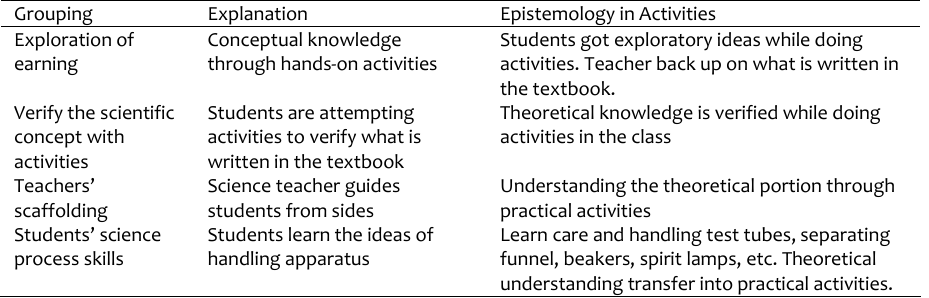
Table 1: Epistemological Orientation in Chemistry Lesson